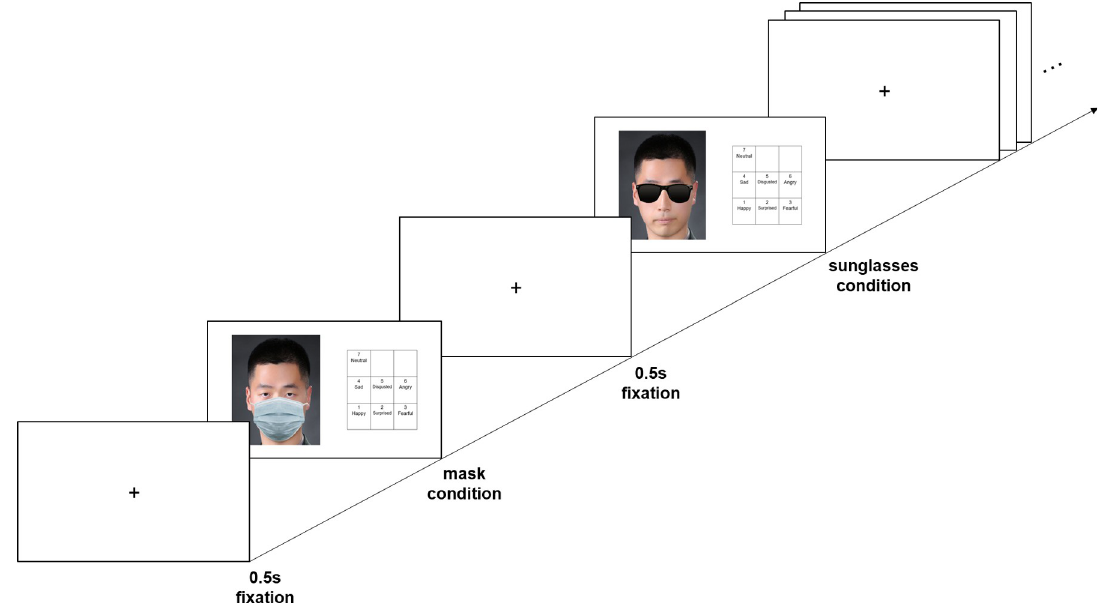
Fig 1. An example of the facial expression recognition task. Participants chose the emotional example that aligned to the facial expressions presented after 0.5-second fixation. All facial stimuli were presented randomly. Due to copyright, the presented face is an example photo, not